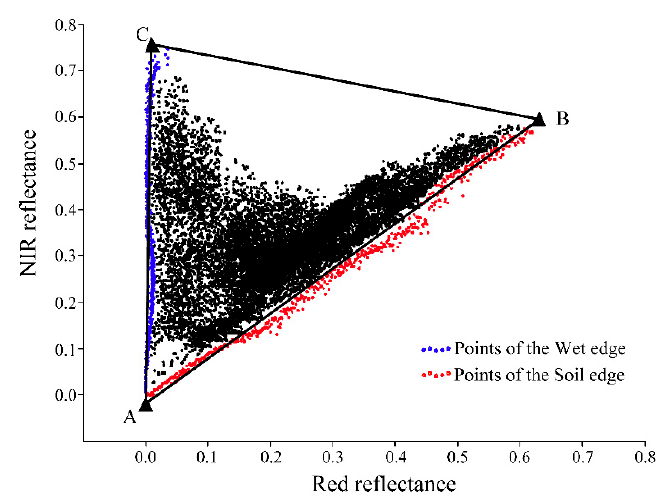
Figure 10. The triangle distribution of the NIR and red bands values in the NIR–Red spectral space generated with real Landsat-8 OLI data. The yellow points represent the soil pixels and the blue points represent the wet pixels.